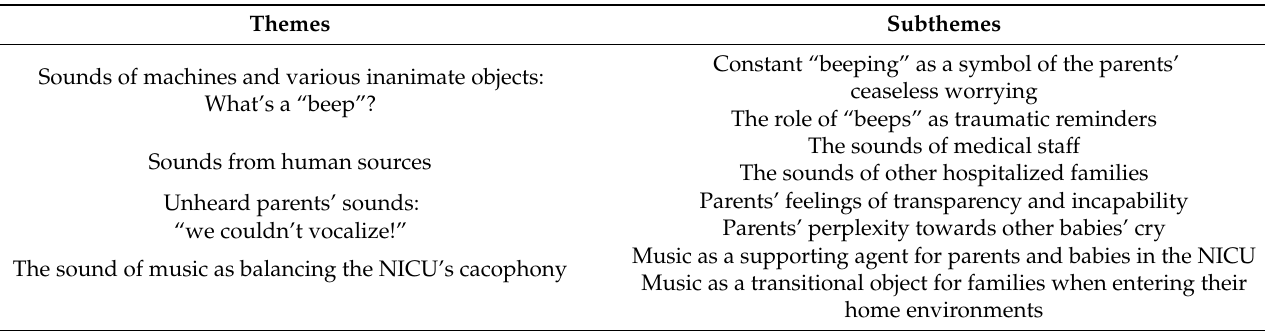
Table 8. Qualitative analysis of themes and